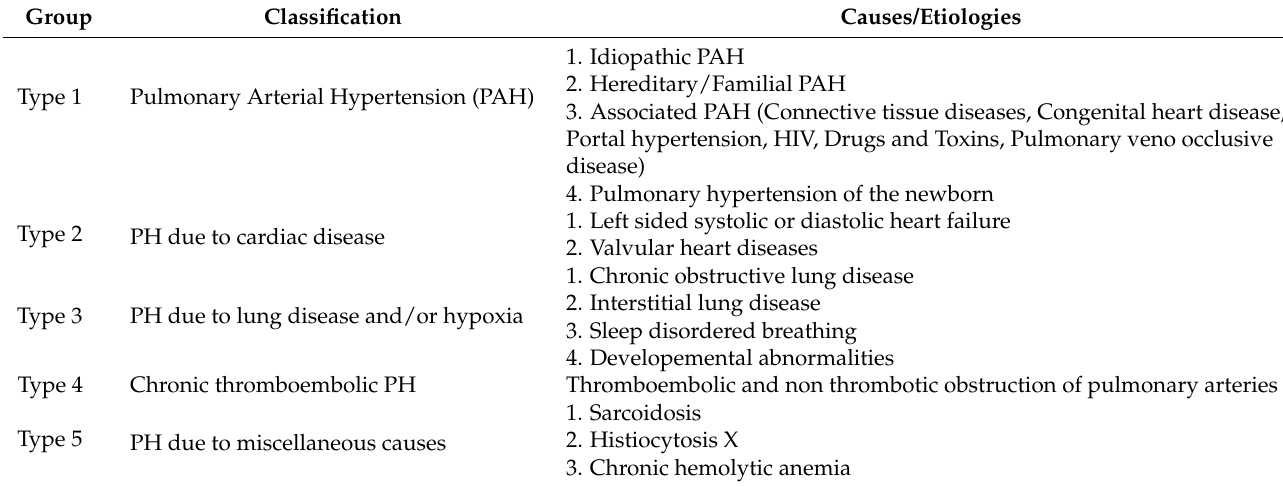
Table 1. Classification of Pulmonary